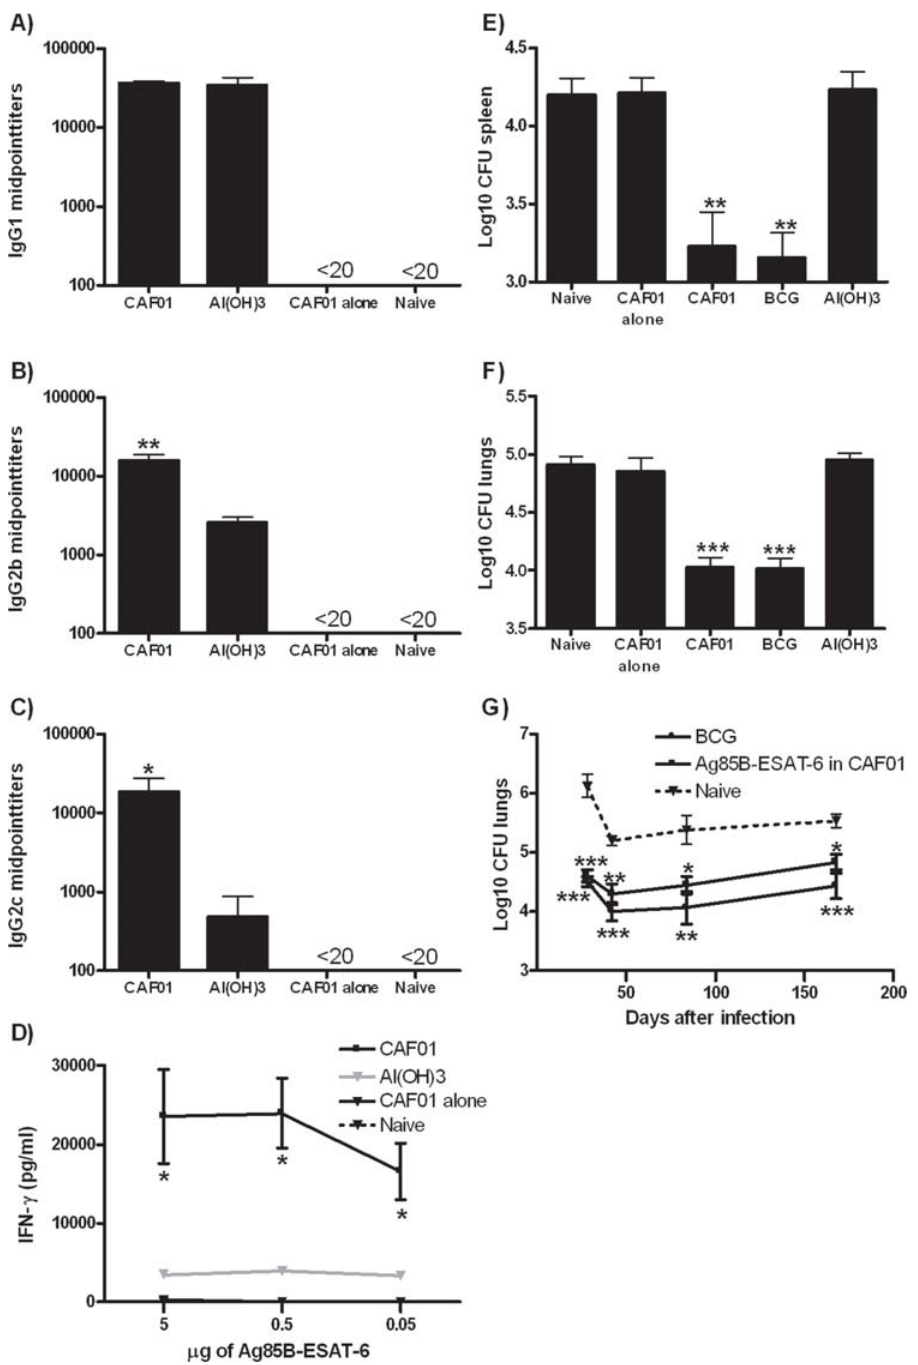
Figure 3. Immune responses and protection induced by CAF01 in a TB model. C57BL/6 mice were immunized three times with 2 m g of Ag85B-ESAT-6 in CAF01 or Al(OH) 3 . A) Three weeks after the last immunization, mice were bled by periorbital puncture and individual sera tested for Ag85B-ESAT-6 IgG1, B) IgG2b or C) IgG2c by ELISA (n=6). D) Individual cultures of splenocytes (n=3) were harvested at the same time point and re- stimulated in vitro with different concentrations of the Ag85B-ESAT-6. The release of IFN- c was determined by ELISA. Six weeks after the last immunization, mice were challenged by the aerosol route with virulent M. tuberculosis . Six weeks postchallenge, mice were sacrificed and the bacterial burden (CFU) measured in the E) lungs or F) spleen (expressed as log 10 CFU). As a positive control group, a group of mice received a BCG vaccination ten weeks before challenge. Data shown are mean values of six mice 6 SEM. G) At different time points after infection, mice were sacrificed and the CFU measured in the lungs. Values marked with an asterisk are significantly different (*, p , 0.05; **, p , 0.01, p , 0.001) compared to naı¨ve controls as assessed by ANOVA and Dunnett’s multiple comparison test.